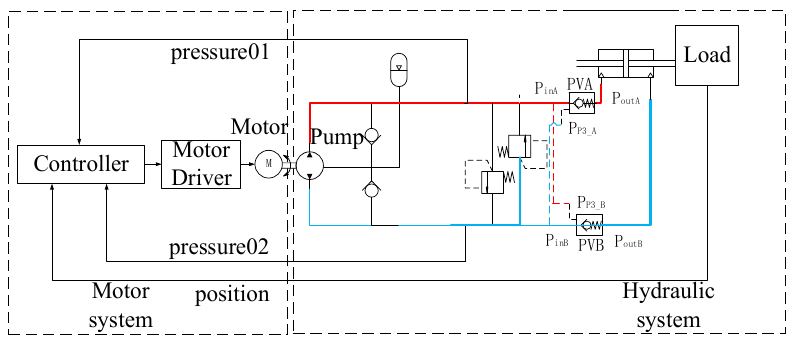
Figure 13. Operating mode A of the EHA.